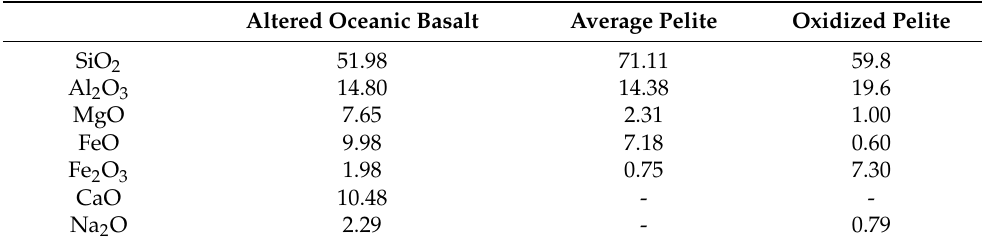
Table 1. Bulk compositions used in the thermodynamic modeling (in wt.%, H 2 O in access). Altered Oceanic Basalt Average Pelite Oxidized